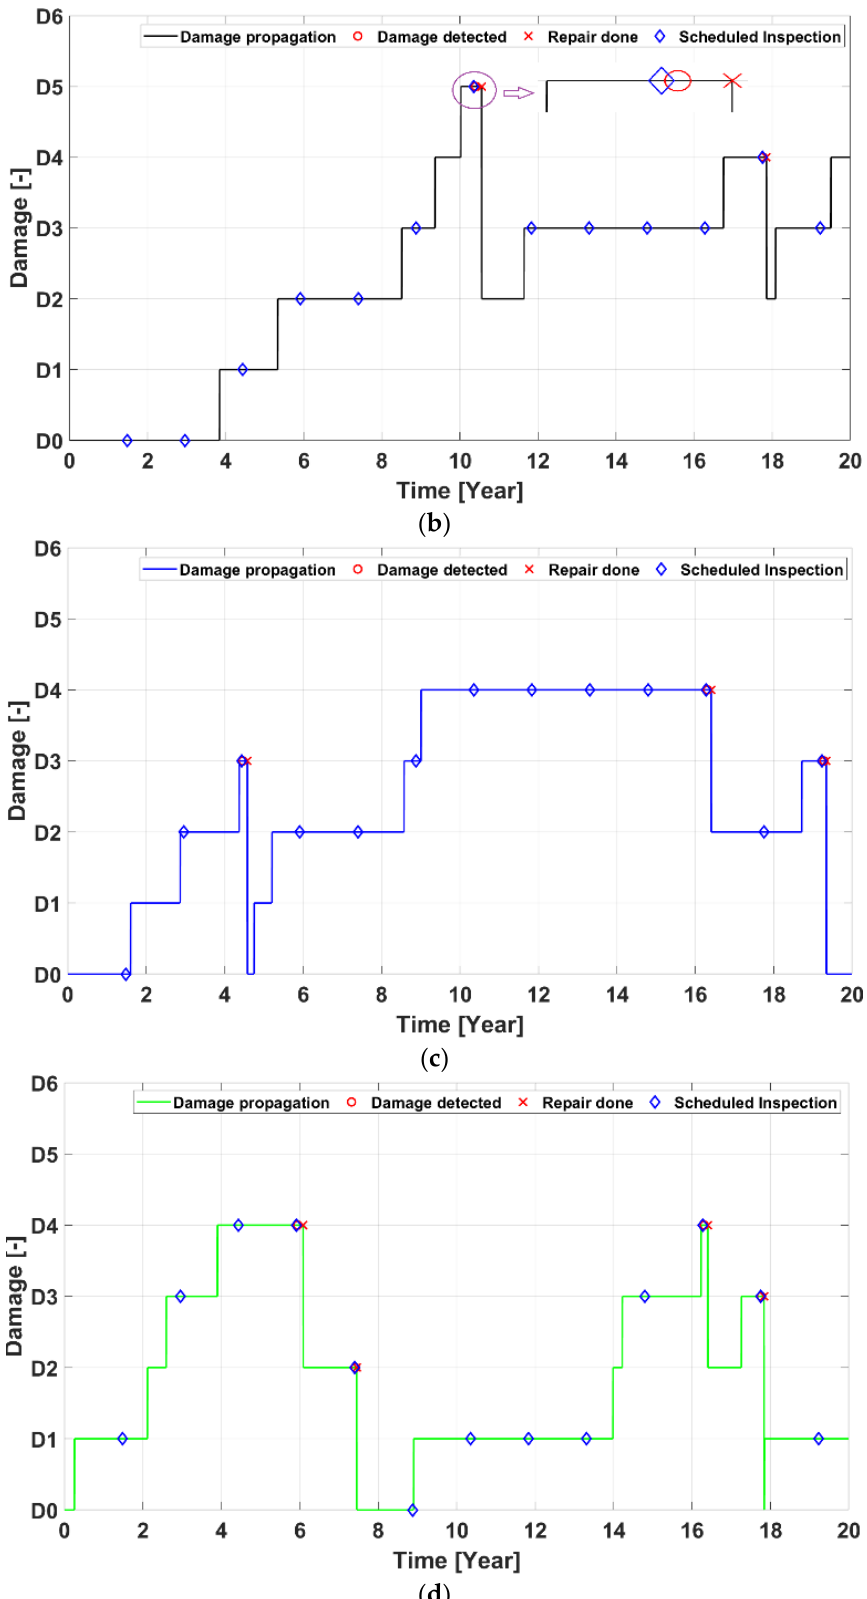
Figure 4. Realizations of the stochastic damage propagation. (a): Three Realizations; (b): 1st Realization; (c): 2nd Realization ; (d): 3rd Realization.